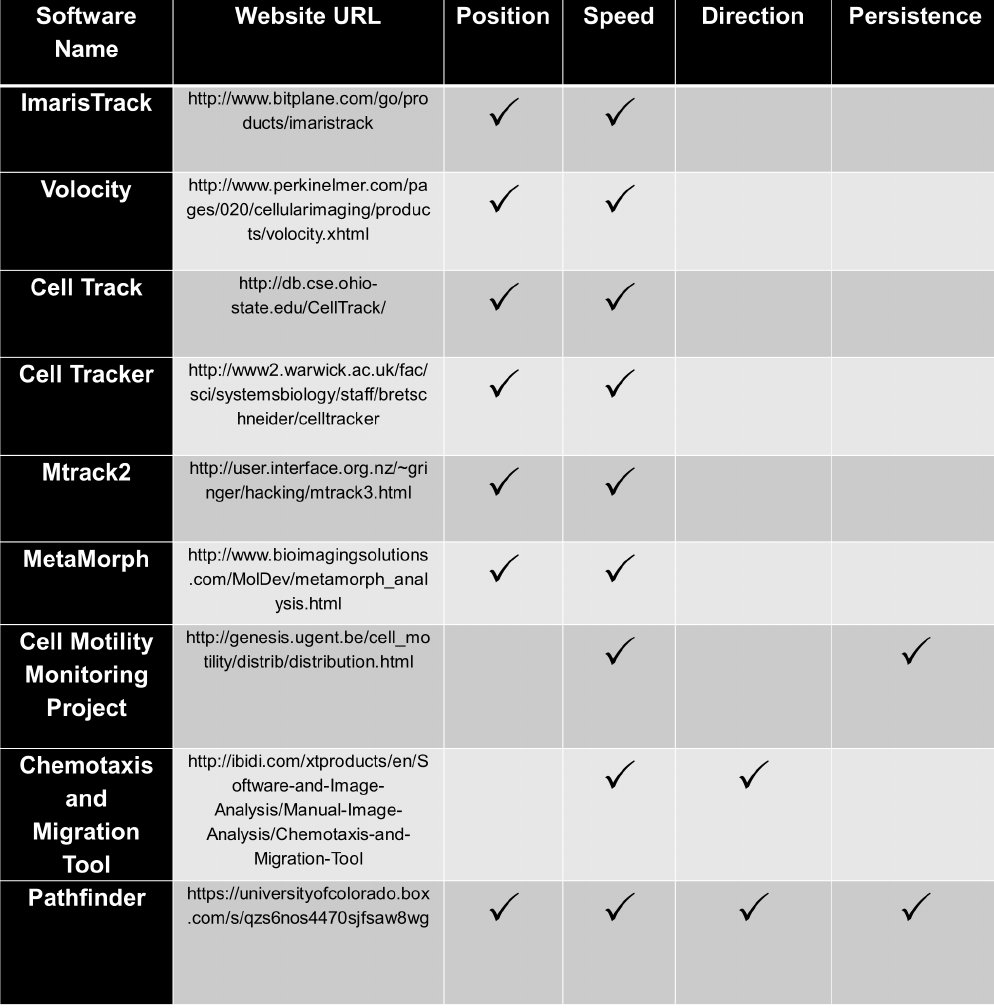
Figure 1. The Pathfinder cell motility program uniquely incorporates measurements of cellular position, speed, direction, and persistence. Although several cellular motility programs are available to measure cellular motility in terms of position and speed, only the Pathfinder program additionally reports both cellular migration direction and cellular migration persistence.